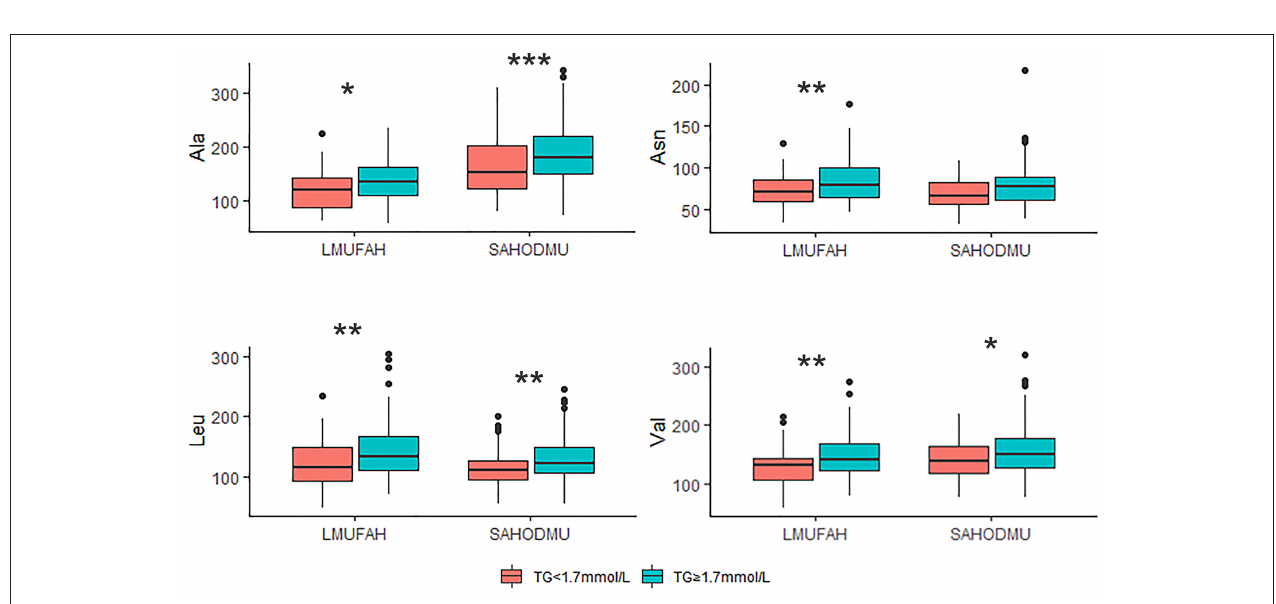
FIGURE 2 | Plasma amino acids levels in patients with LDL-C < 2.6 mmol/L according to TG levels. LDL-C, low-density lipoprotein cholesterol; TG, triglyceride; LMUFAH, Liaoning Medical University First Affiliated Hospital; SAHODMU, the Second affiliated hospital of Dalian Medical University; Ala, Alanine; Asn, Asparagine; Leu, Leucine; Val, Valine. * P < 0.05; ** P < 0.01; *** P < 0.001.